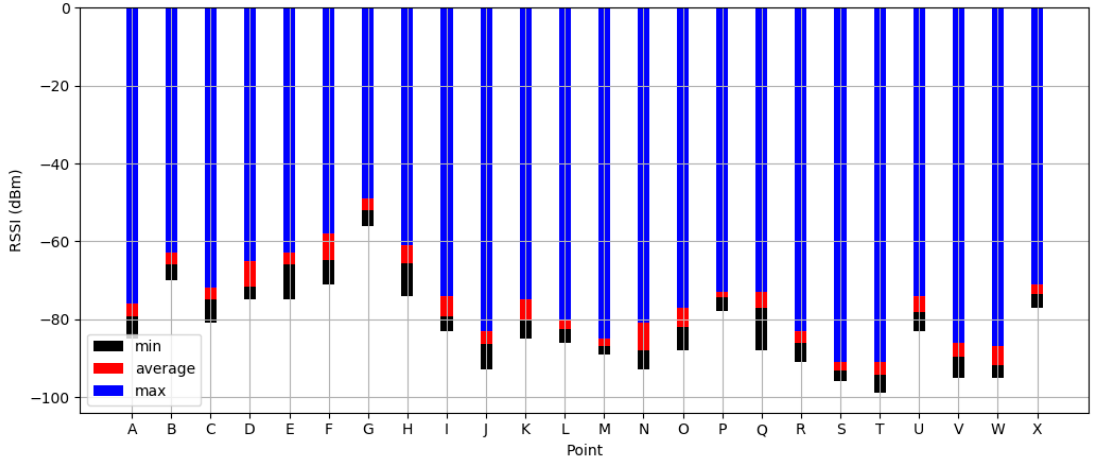
Figure 2. Experimental results of the process whereby predefined landmarks are found.